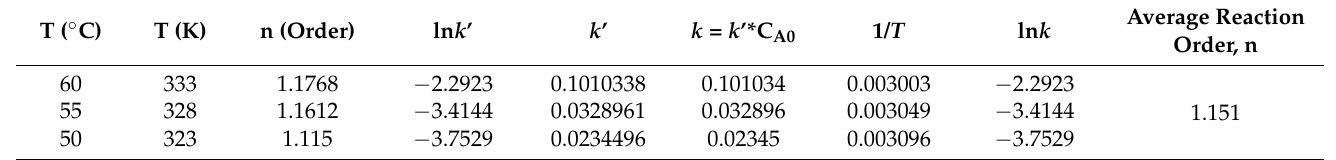
Table 1. 1/ T vs. ln k for the WCO esterification process kinetic